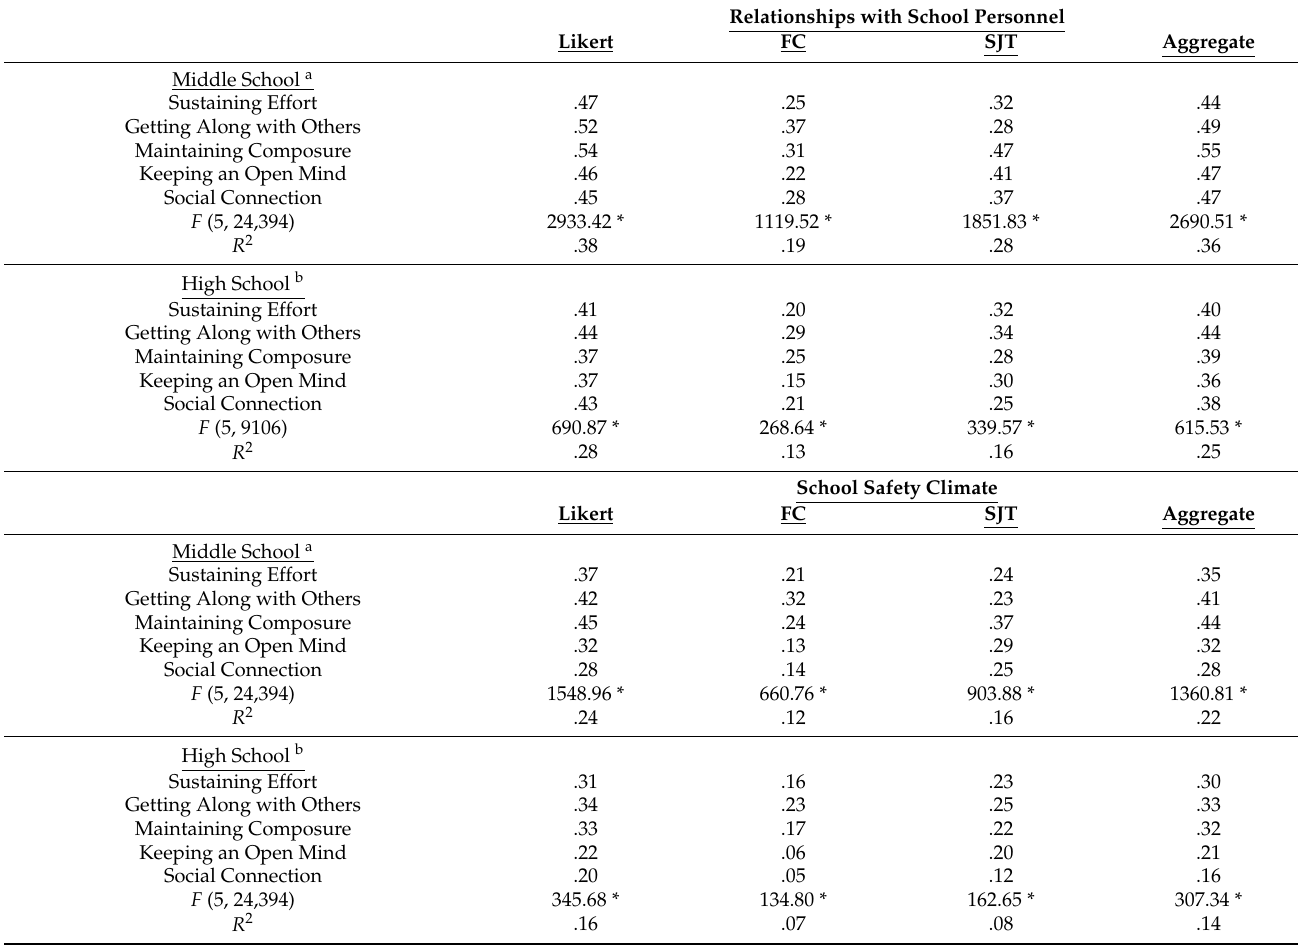
Table 3. Associations Between Mosaic Skills and Outcome Variables: Correlations and Regression